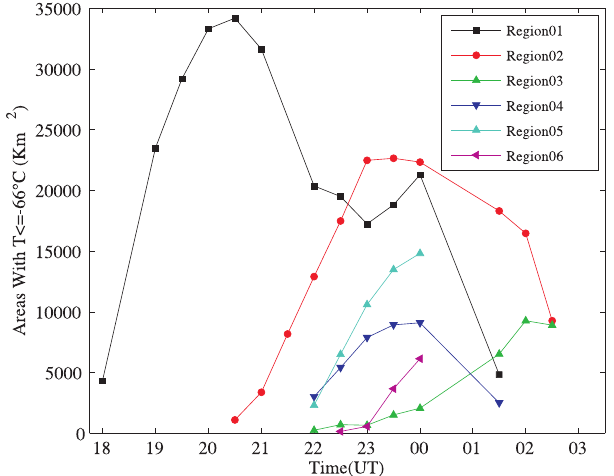
Fig. 5. Overall cloud cover ( T < − 66 ◦ C) temporal evolution of 30 September–1 October 2005 convective